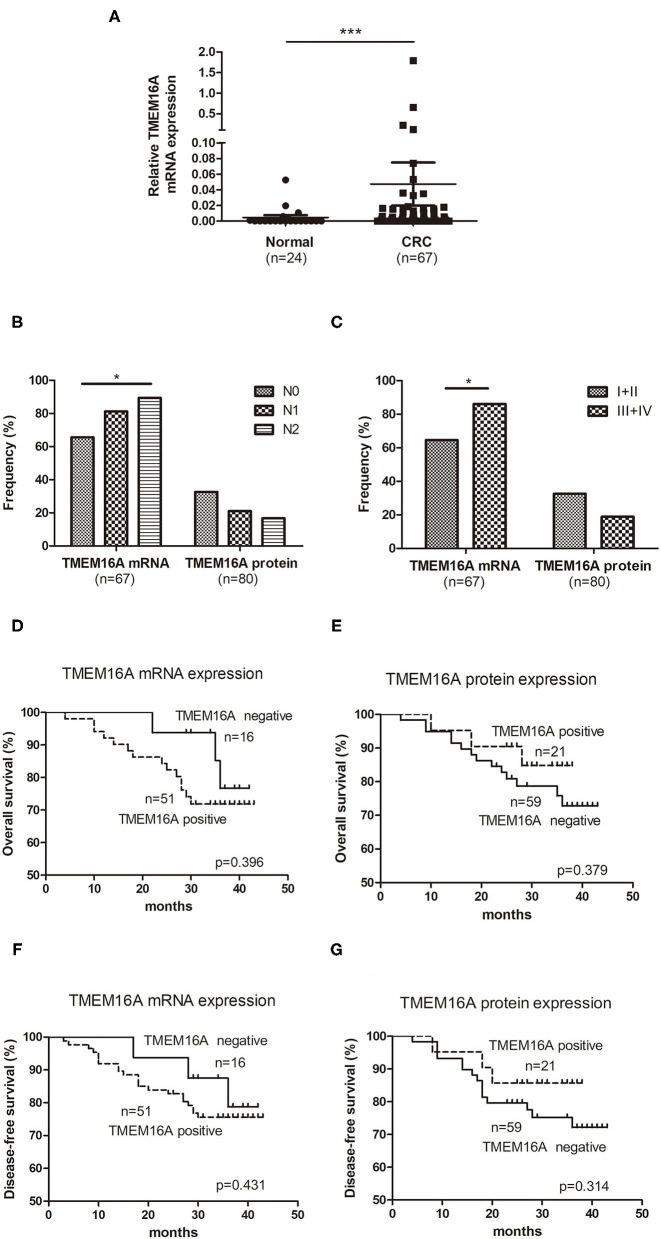
Expression of TMEM16A in colorectal carcinoma and its correlation with overall survival. (A) Quantitative RT-PCR results showed that the expression of TMEM16A in colorectal cancer was significantly higher than that in normal colorectal tissue (***P < 0.0001). (B) Positive rates of TMEM16A protein expression and mRNA expression in different lymph node status of colorectal carcinoma progression (*P < 0.05). (C) Positive rates of TMEM16A protein expression and mRNA expression in different stages of colorectal carcinoma progression (*P < 0.05). (D) Kaplan-Meier survival curve analysis showed that CRC patients with TMEM16A mRNA expression tended to a worse overall survival. (E) Kaplan-Meier survival curve analysis about effect of TMEM16A protein expression on patient verall survival. (F) The effect of TMEM16A mRNA expression on disease-free survival was analyzed by Kaplan Meier survival curve. (G) The effect of TMEM16A protein expression on disease-free survival was analyzed by Kaplan Meier survival curve.